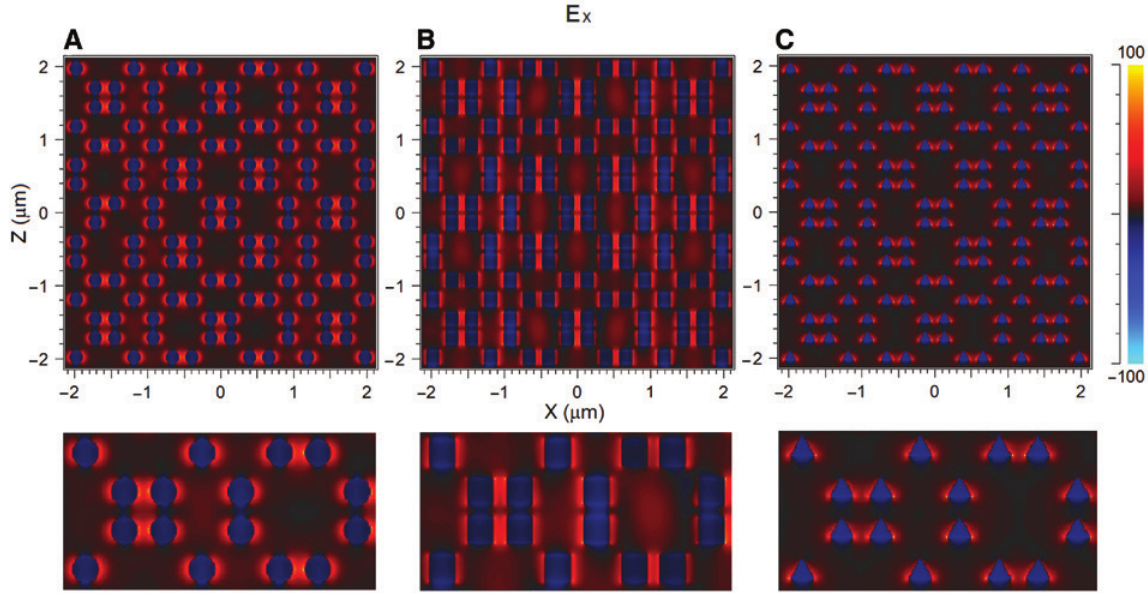
Figure 2: Electric component (Ex) distributions calculated by FDTD method for plasmonic ThMo nanostructures with minimum interparticle distance a = 80 nm and different NPs shape: (A) circular, (B) square, (C)